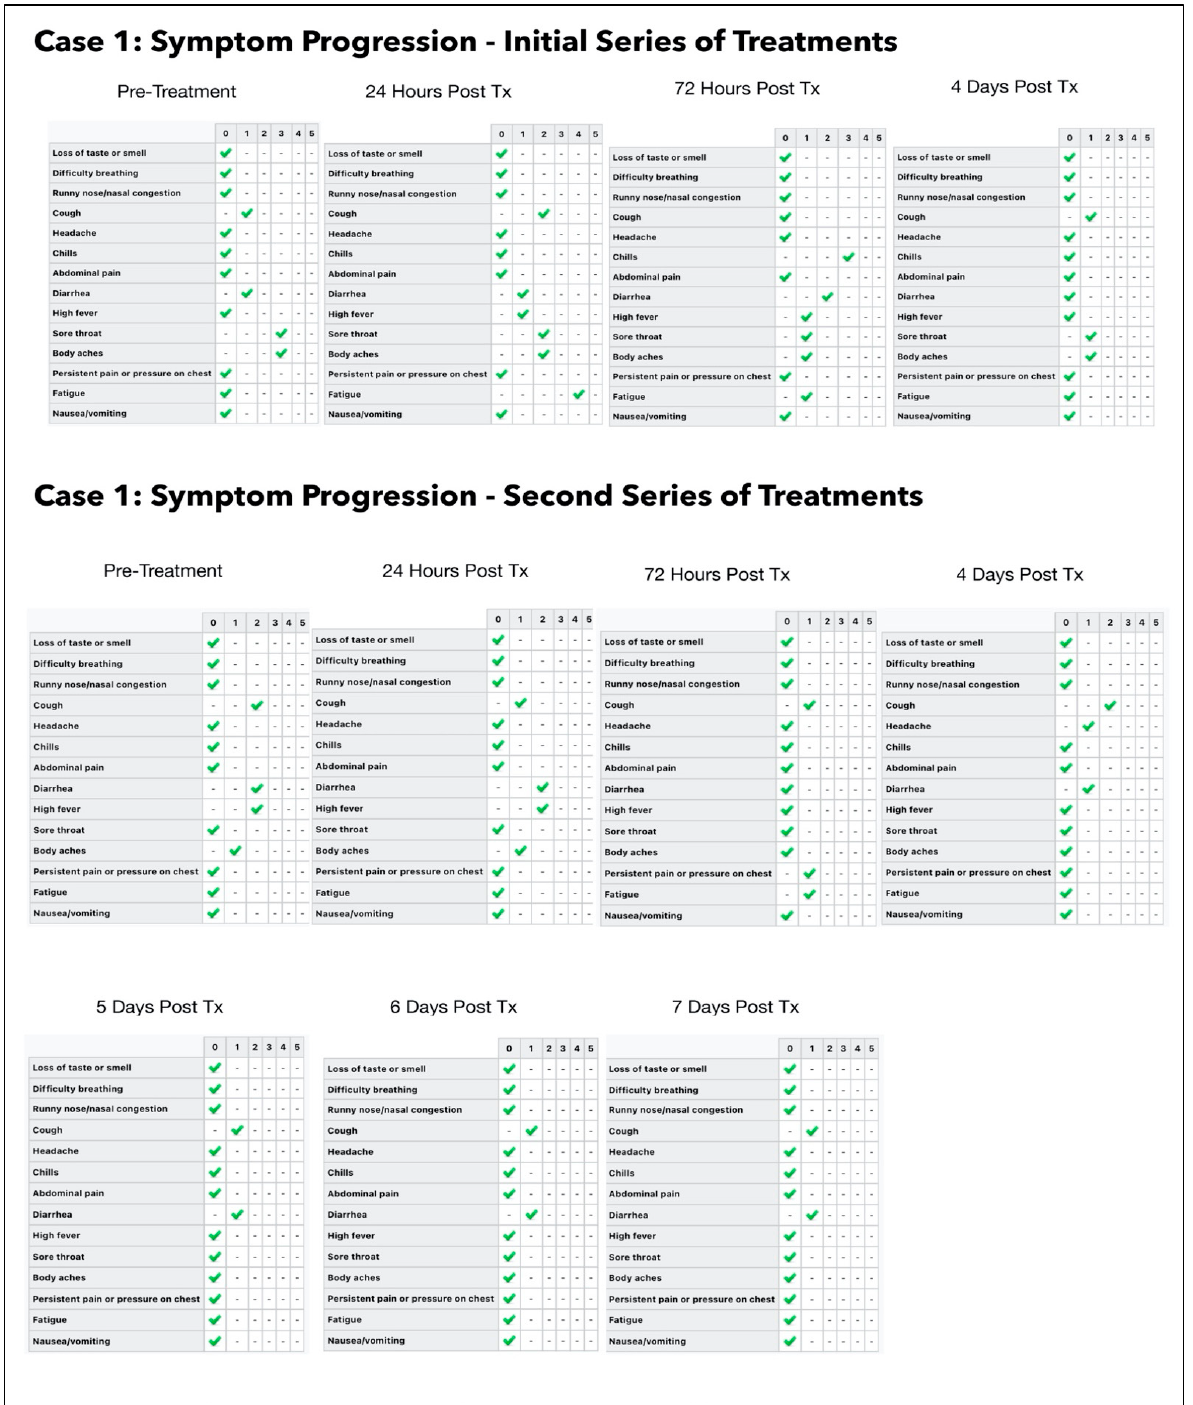
Figure 5. Shows the symptom progression on the initial and second series of treatments. The recorded symptoms were loss of taste and smell, difficulty in breathing, runny nose/nasal congestion, cough, headache, chills, abdominal pain, diarrhea, high fever, sore throat, body aches, persistent pain or pressure on chest, fatigue, nausea/vomiting. The symptom scale ranges from 0–5, where 0 score represents absence of symptoms and 5 score represents extreme